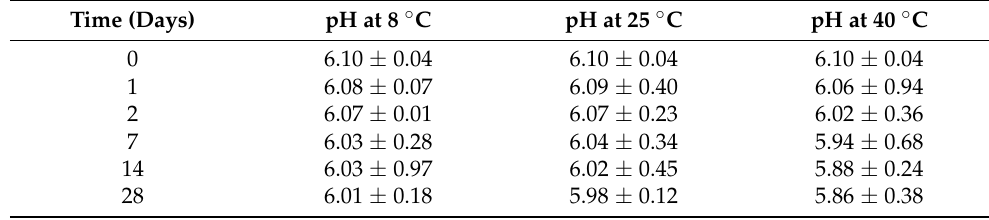
Table 2. pH of optimized naproxen-eugenol emulgel at different temperatures and duration of time. Time (Days)